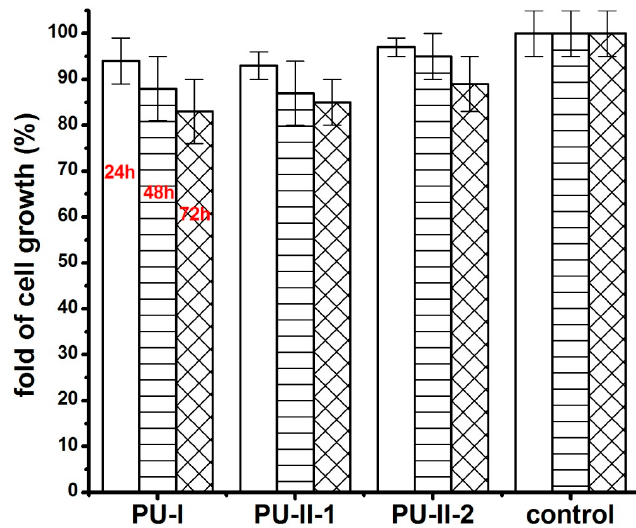
Figure 10. The effect of polymer extracts on the in vitro cell growth of MG 63 studied by MTT assay after 24 h, 48 h and 72 h.